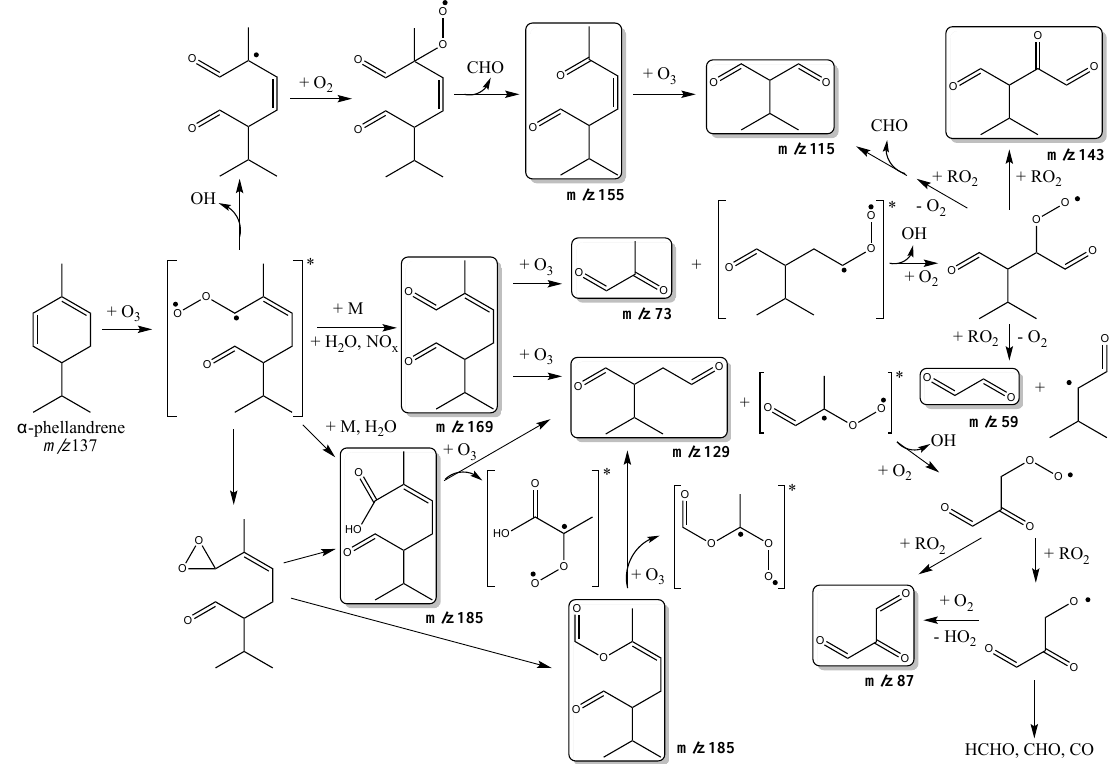
Figure 3. Partial mechanism for the ozonolysis of α -phellandrene starting from CI3, yielding product masses detected by the PTR-TOF. Similar constructs for the remaining CIs are provided in the Supplement (Sect.